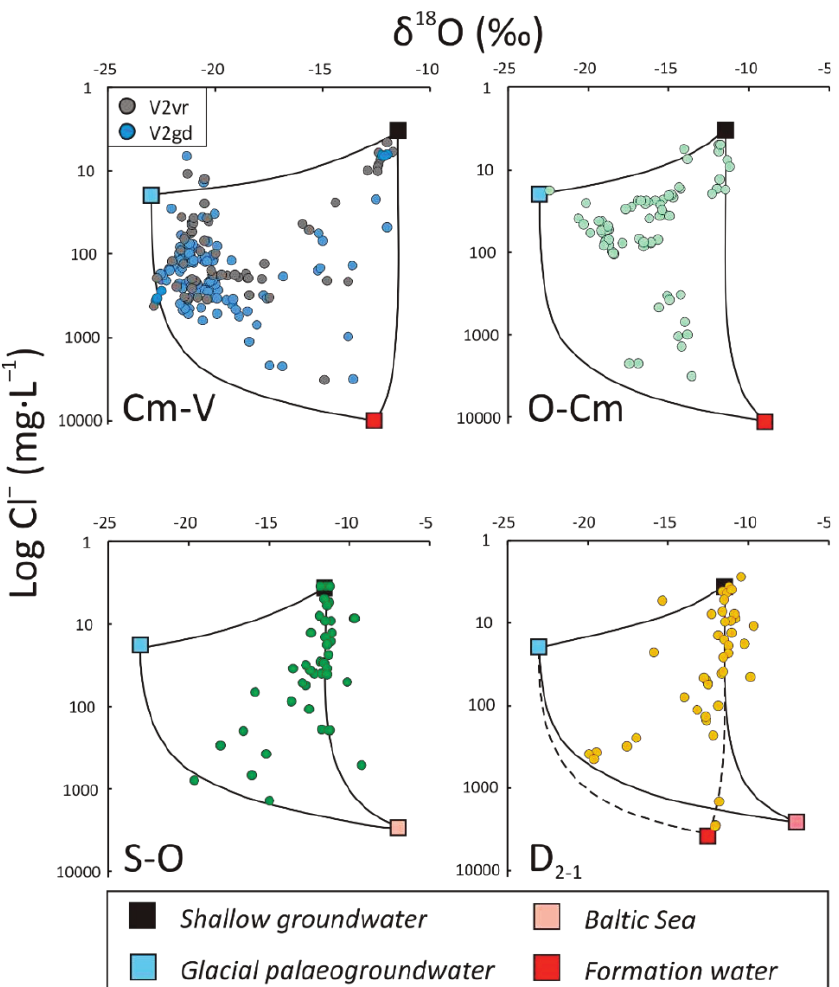
Fig. 4. Mixing relationships in the Baltic Artesian Basin (BAB) depicted using conservative tracers δ 18 O and chloride for several aquifer systems in the northern part of the BAB. The end-member values for δ 18 O and chloride are the following: shallow groundwater (–11.7‰, 4 mg L –1 ), glacial palaeogroundwater (–23‰, 20 mg L –1 ), the Baltic Sea (–7.0‰, 3735 mg L –1 ), formation water (Cm–V: –12.6‰, 9800 mg L –1 ; O–Cm: –9‰, 11 438 mg L –1 ; D 2–1 : –12.5‰, 3740 mg L –1 ). Abbreviations: Cm–V – Cambrian–Vendian aquifer system (equivalent of the CVAS in the northern part of the BAB), V2vr – Voronka aquifer, V2gd – Gdov aquifer; O–Cm – Ordovician–Cambrian aquifer system; S–O – Silurian–Ordovician aquifer system; D 2–1 – Lower–Middle Devonian aquifer system. From Pärn